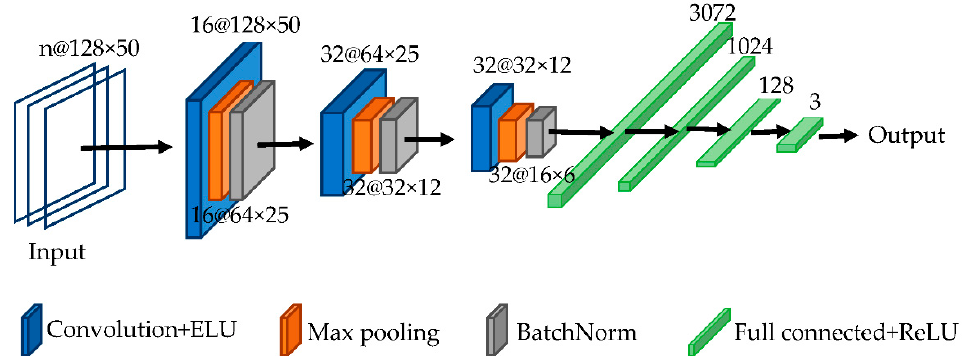
Figure 1. Multi-channel time–frequency convolutional neural